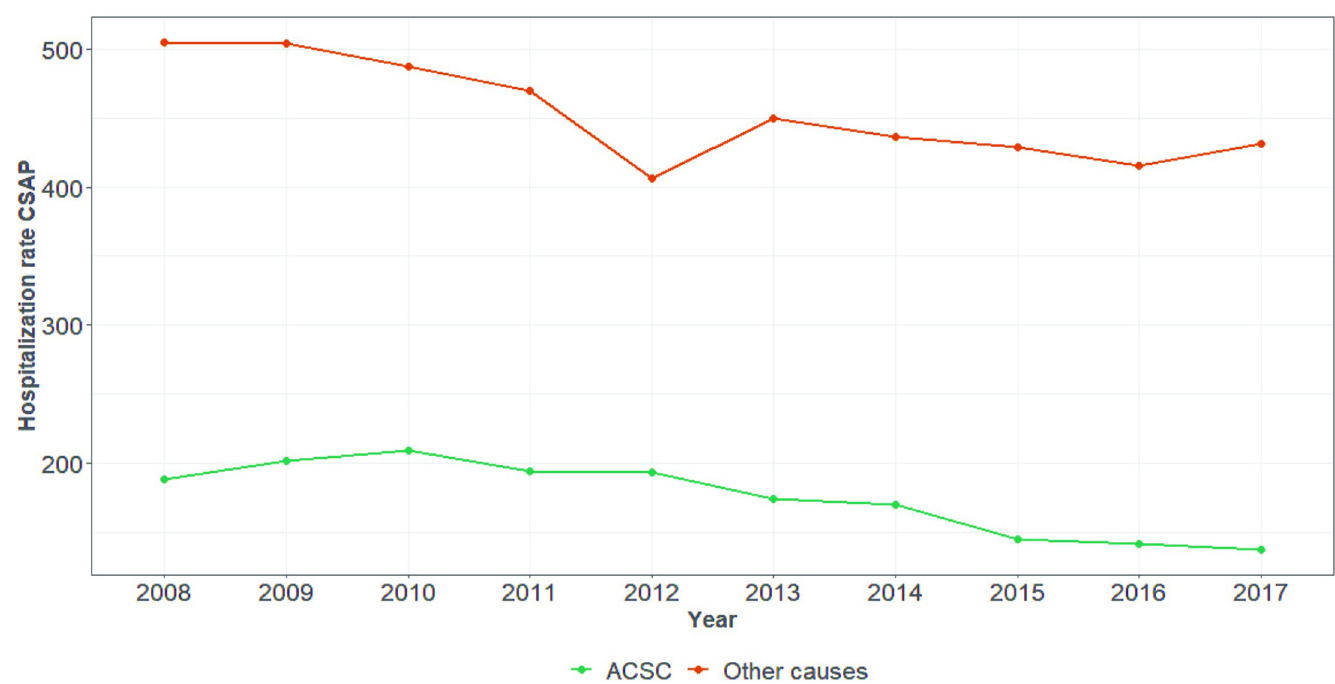
Fig 2. Evolution of the hospitalization rate by type of hospitalization in Para´, 2008–2017. Source: SIH/DATASUS.